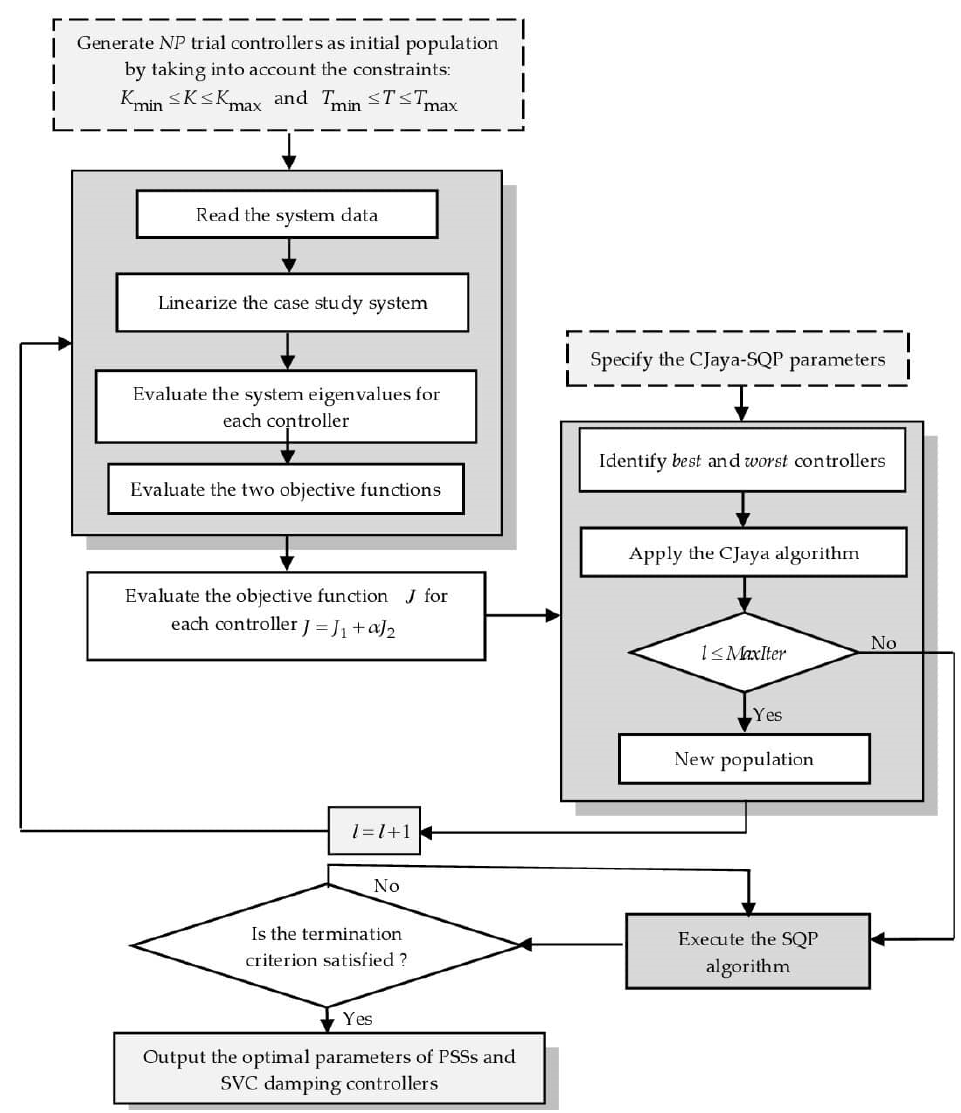
Figure 10. Application of CJaya-SQP for PSSs and SVC controllers design.